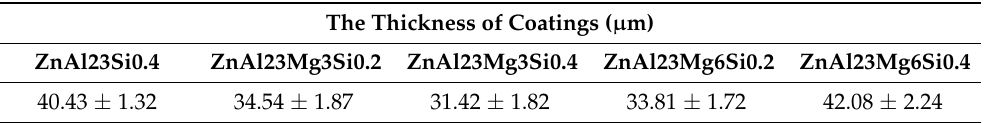
Table 8. The average thickness of coatings on samples for corrosion tests.